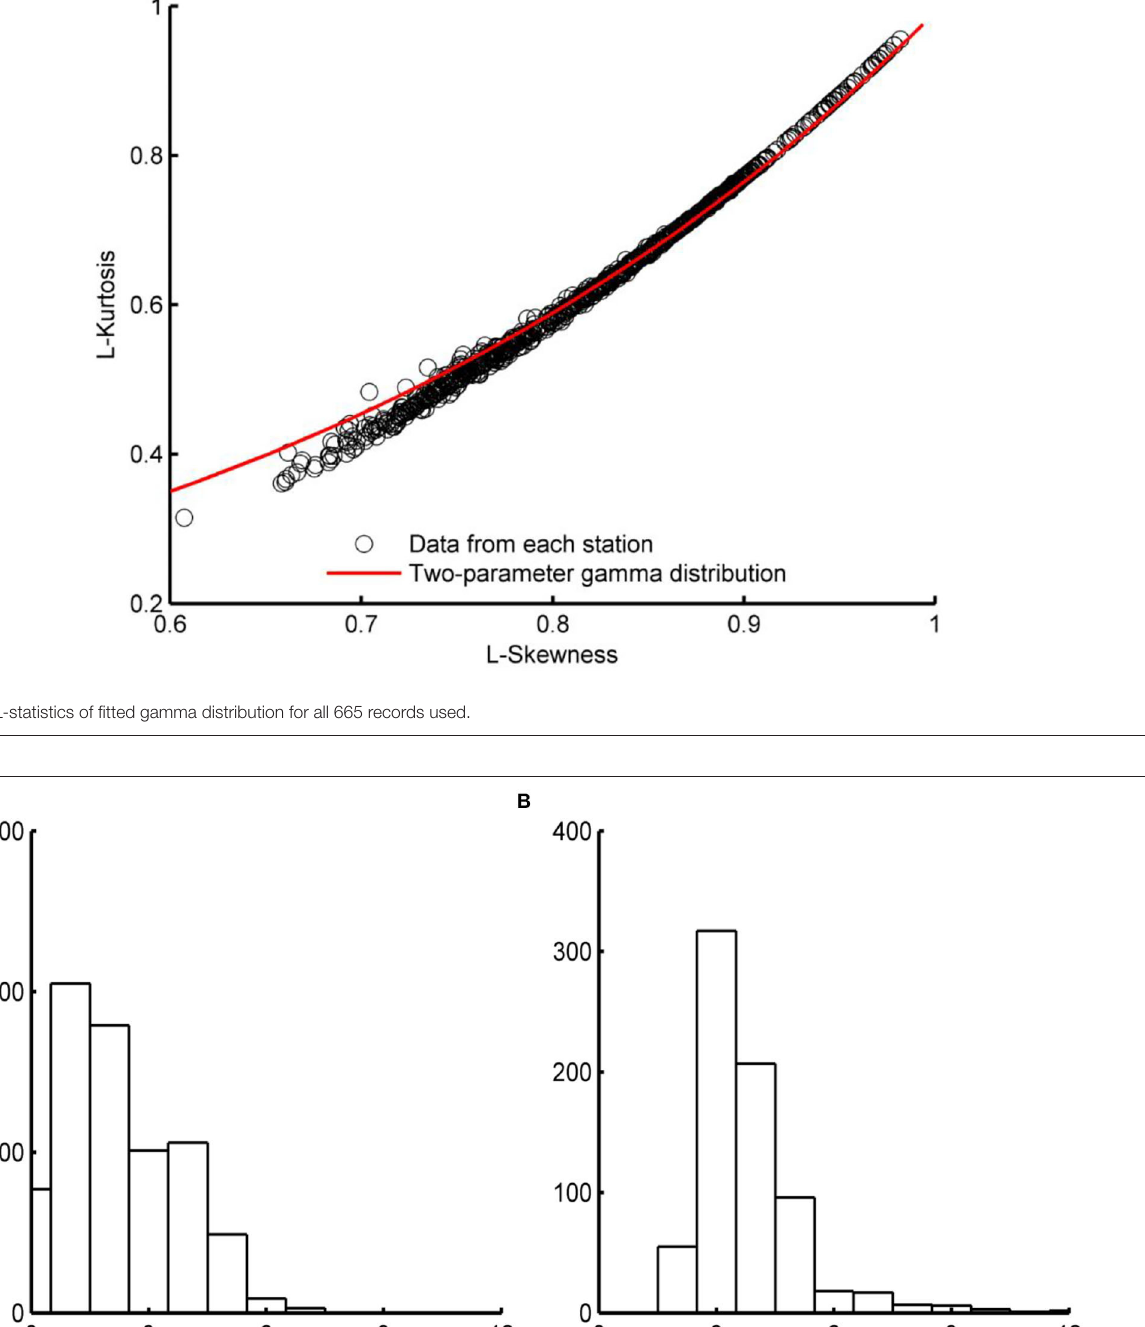
series at scale 1 to be about 665